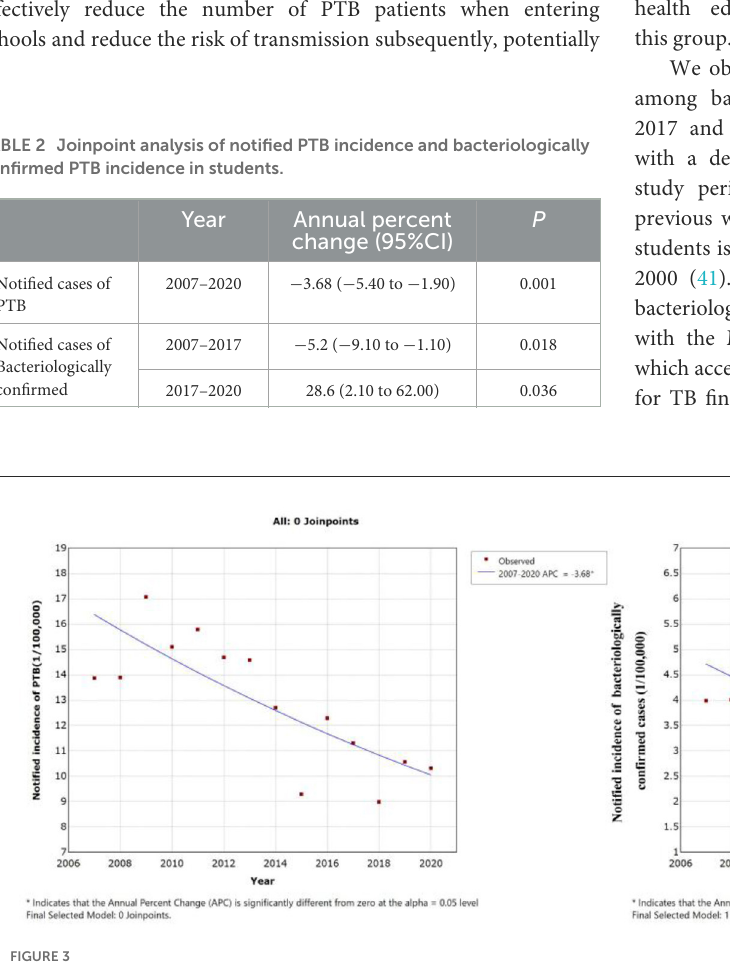
FIGURE3 Joinpoint regression analysis of notified PTB incidence in students: (A) Time trend of all notified PTB cases. (B) Time trend of bacteriologically confirmed PTB cases.